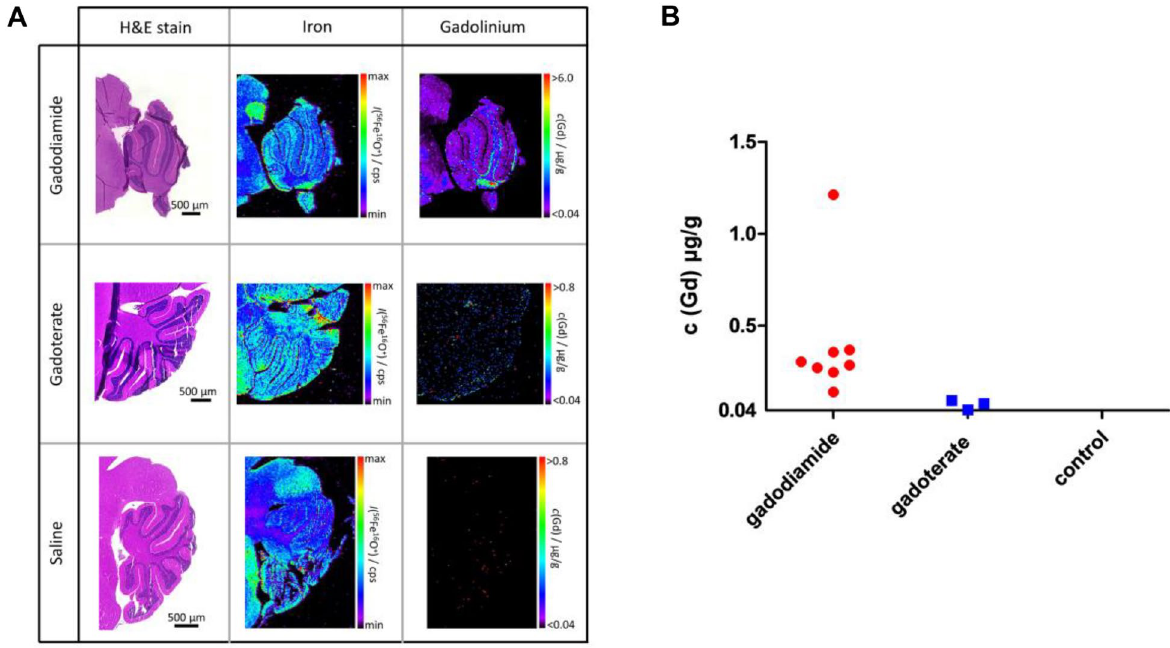
Figure 3. Distribution of gadolinium and iron in the cerebellum of mice after GBCA or control treatment. Example photomicrographs of H&E-stained cerebella after gadodiamide, gadoterate and saline administration with respective qualitative iron and quantitative gadolinium distribution analyzed by LA-ICP-MS ( A ). Gd concentration in each sample is illustrated ( B ), if above the limit of quantification of 0.040 µg/g (gadodiamide group: 8/8 samples above limit of quantification; gadoterate group: 3/8; control group: